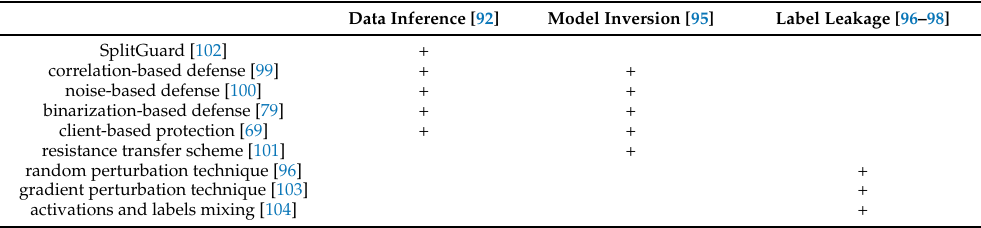
Table 6. Privacy attacks to split learning and representative protection